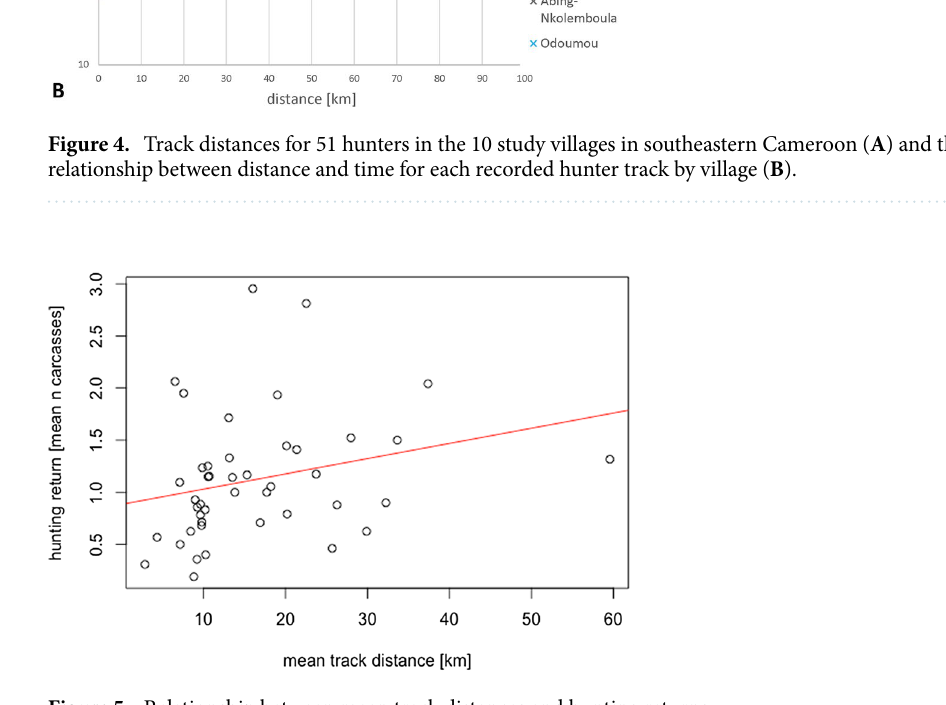
Figure 5. Relationship between mean track distances and hunting